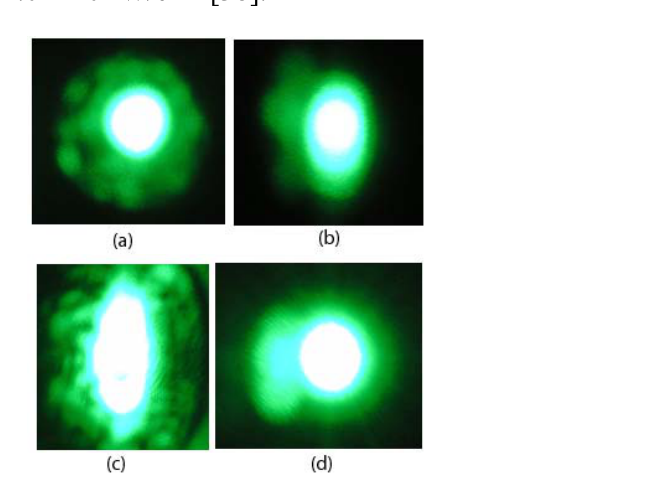
Figure 1. Distortion of Transmitted Argon Laser Beam Spots after 5 min of Irradiation.